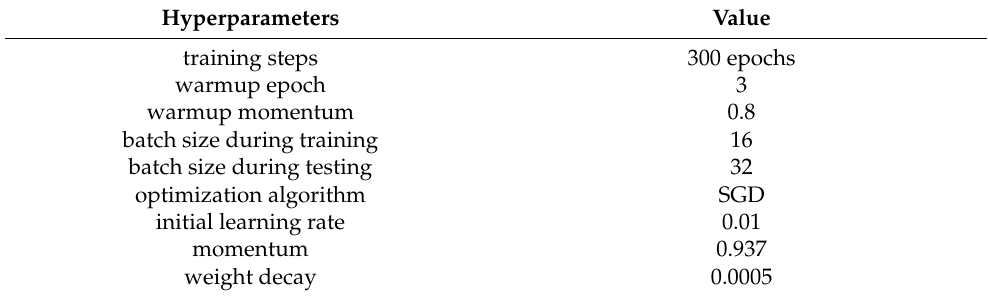
Table 3. The hyperparameters of the